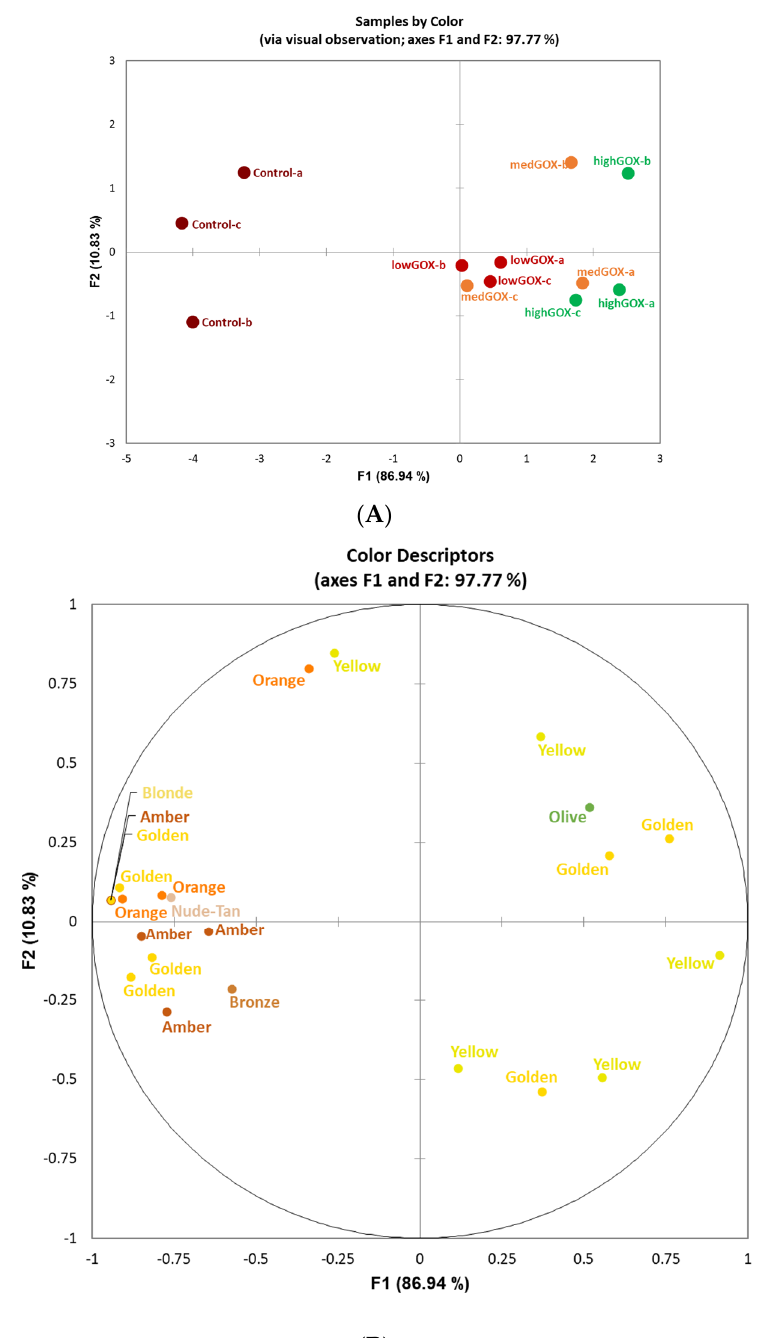
Figure 2. Plots of ( A ) sample consensus space by ( B ) color attributes ( A ). Sample consensus space of untreated (control) samples and GOX-treated samples by level (lowGOX, medGOX, highGOX) and evaluation replicate (a, b, c) resulting from ( B ) color characterization by panelists using flash profile via generalized procrustes analysis. Attribute words are colored to match.